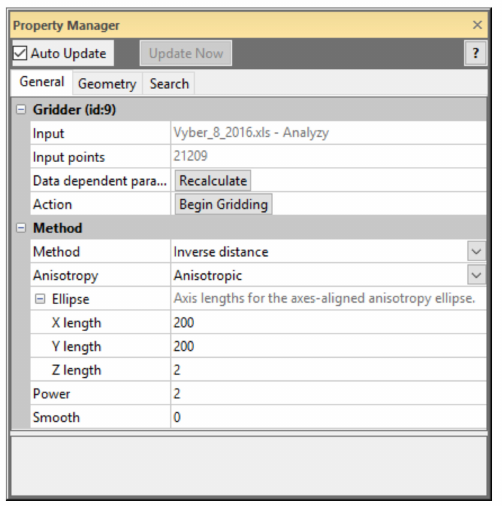
Figure 9. Specified anisotropy parameters for the 3D gridding (object “Gridder”) taken from the initialization